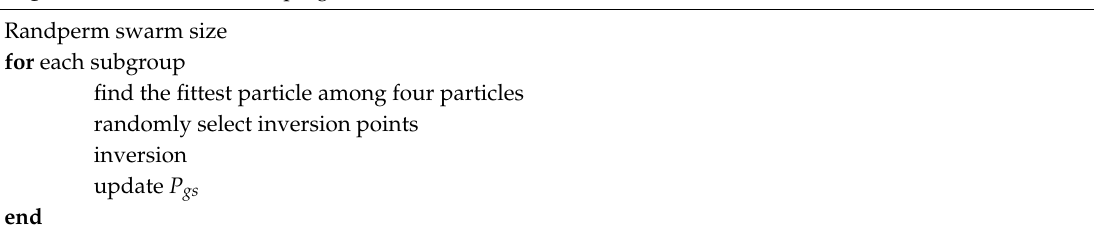
Algorithm 2. Random Grouping Inverion